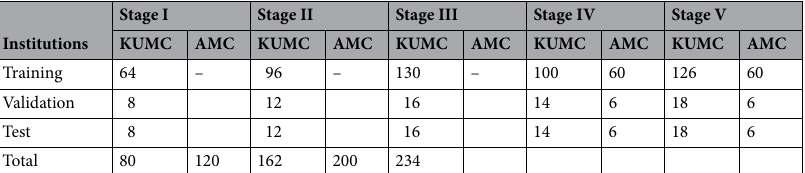
Table 2. The data distribution for training, validation, and test in five stages (KUMC, Korea University Medical Center; AMC, Asan Medical